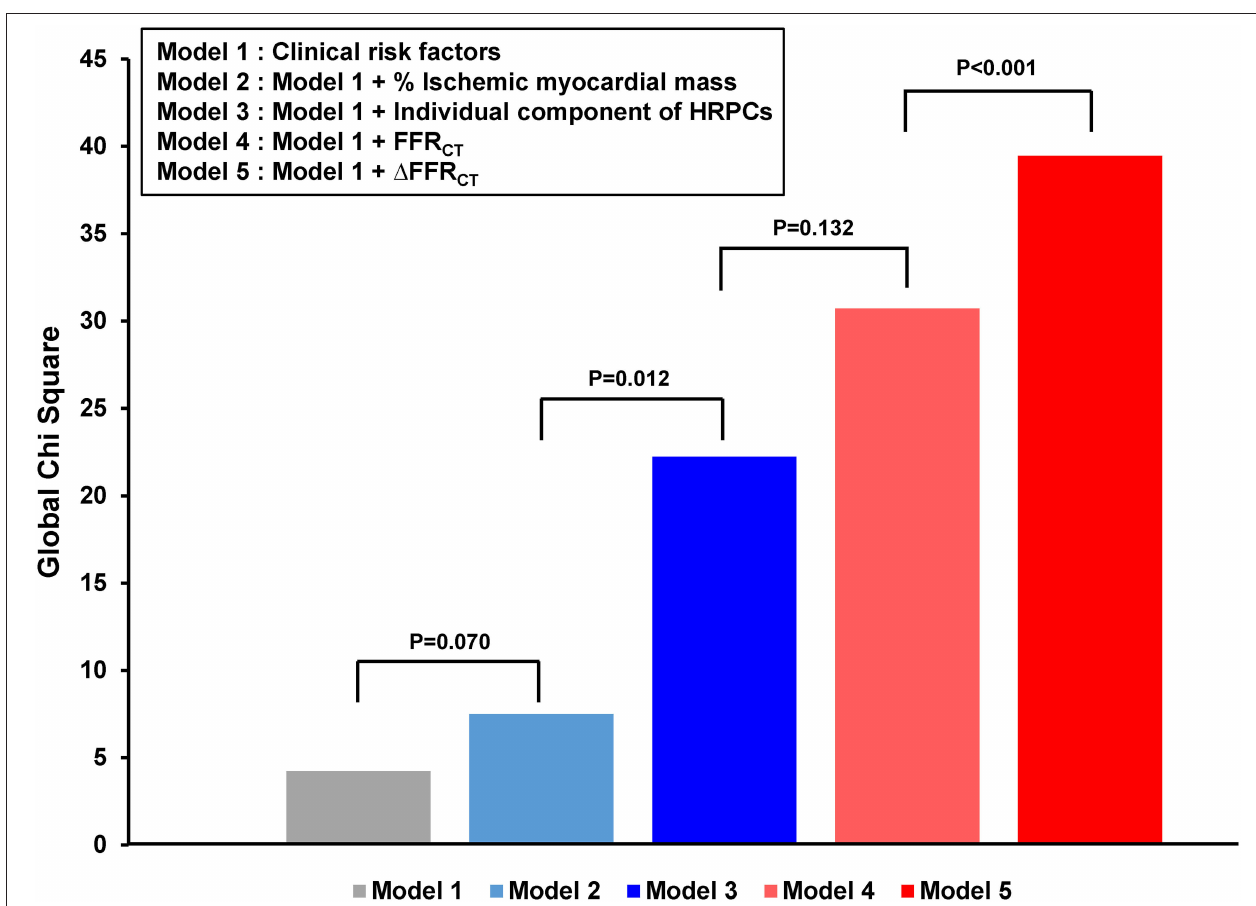
FIGURE 4 | Incremental prognostic impact of HRPCs and hemodynamic parameters for subsequent coronary events. The addition of percent ischemic myocardial mass, HRPCs, 1 FFR CT , and 1 FFR CT into clinical risk factors showed increased predictability for subsequent coronary events. Clinical risk factors included age, sex, hypertension, diabetes mellitus, dyslipidemia, chronic kidney disease, and current smoker. HRPCs included low attenuation plaque, positive remodeling, napkin-ring sign, spotty calcification, minimum luminal area < 4 mm 2 , or plaque burden ≥ 70%. FFR CT , fractional flow reserve by coronary computed tomography angiography; HRPCs, high-risk plaque characteristics.